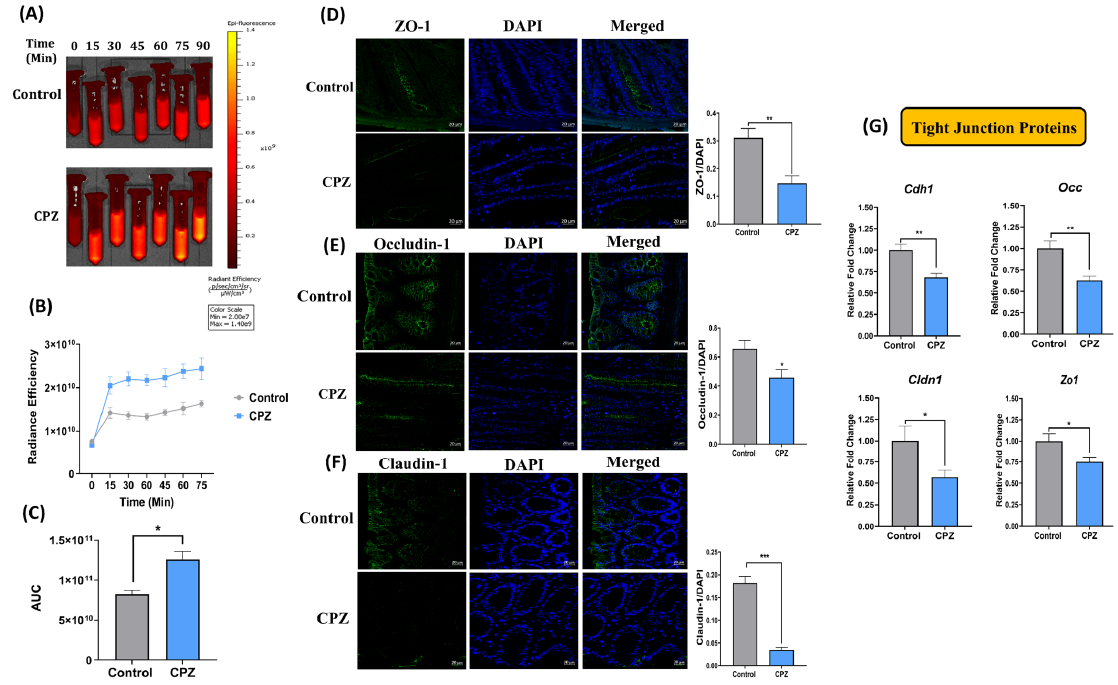
Figure 2. Effect of CPZ rectal administration on intestinal permeability and tight junction proteins.